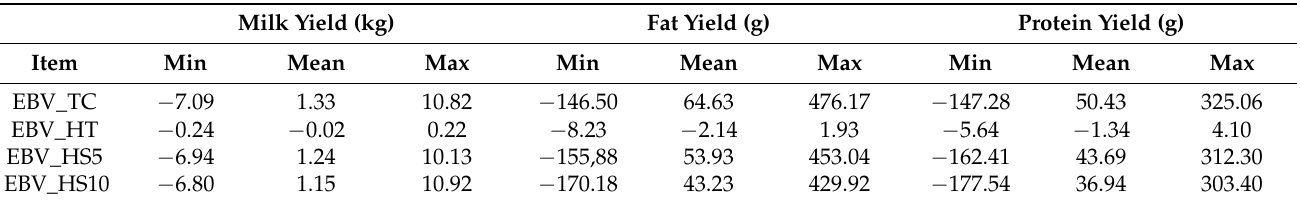
Table 3. Estimated breeding values under thermal comfort (EBV_TC), heat tolerance (EBV_HT), and at five (EBV_HS5) and ten (EBV_HS10) units above the temperature-humidity index threshold (i.e.,